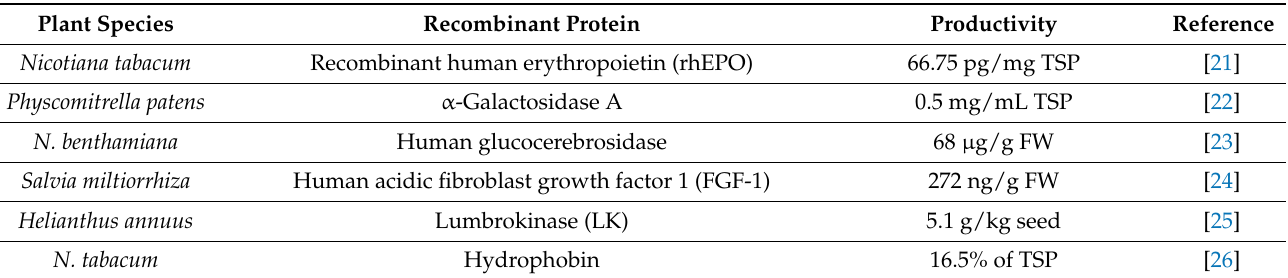
Table 1. Commercial pharmaceutical proteins with stable expression in